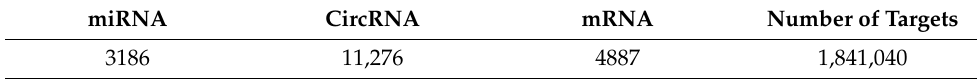
Table 1. C ircRNA new predictive targeting relationship. Table 1. CircRNA new predictive targeting relationship.